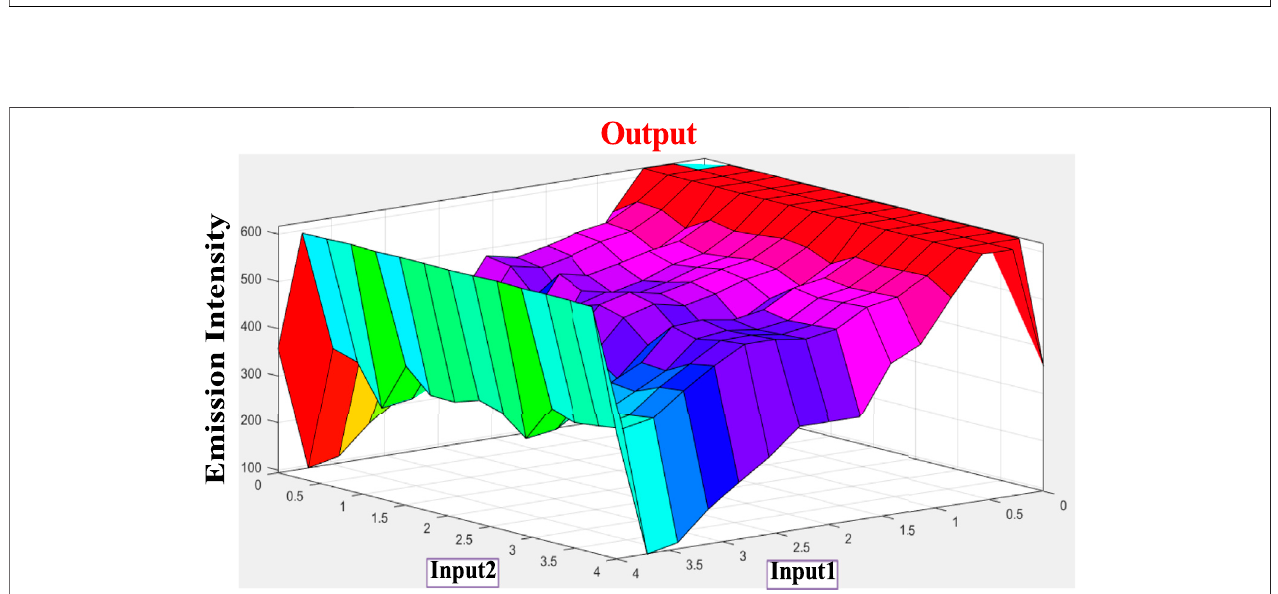
FIGURE 6 | 3D display of the dependence of emission intensity of tpy-HImzPh 3 at 485 nm upon the action of F − and H+.